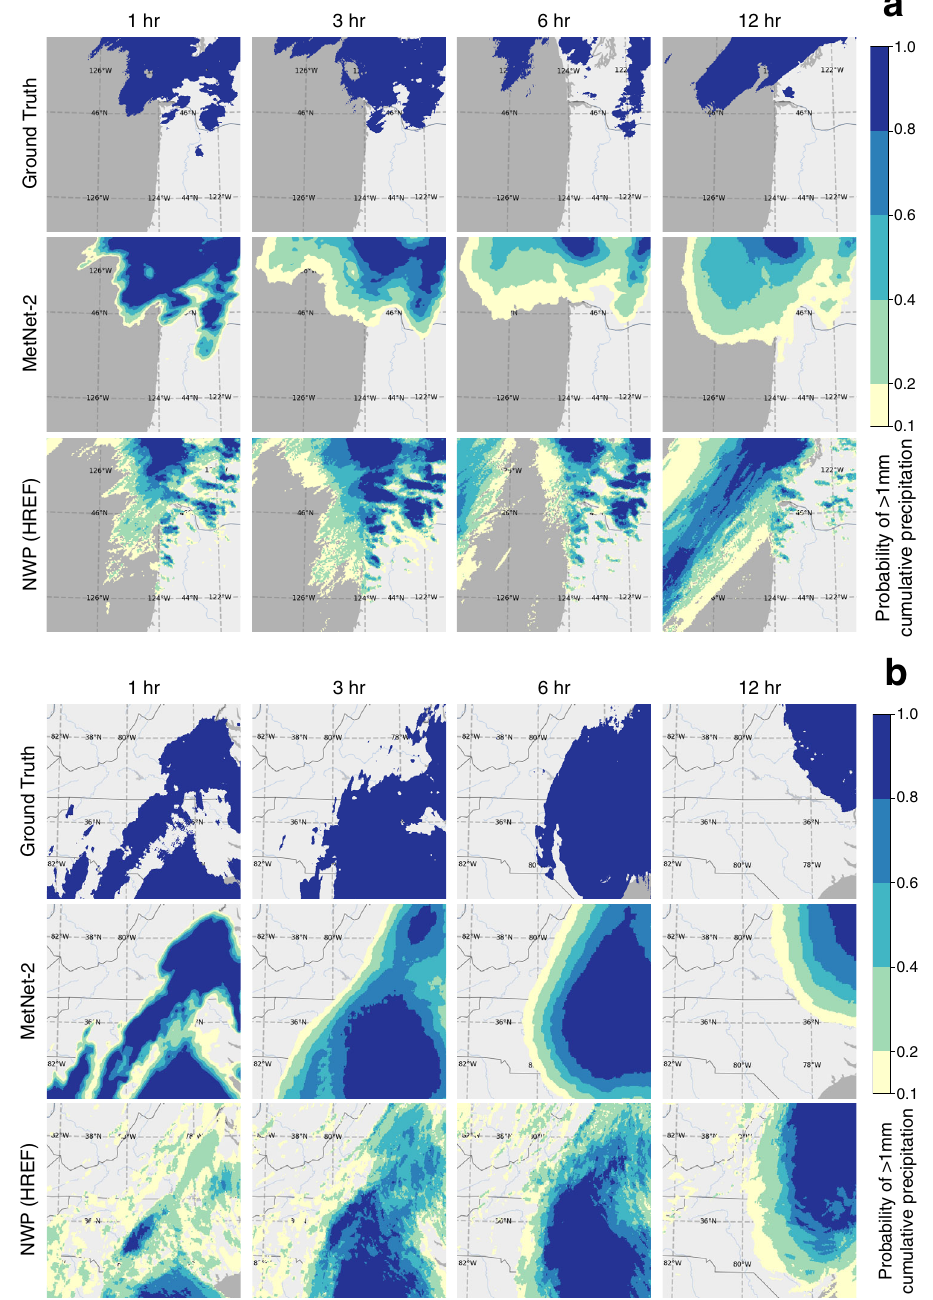
Fig. 4 | Case studies for the models ’ forecasts of cumulative precipitation. Forecasts for gauge-corrected hourly cumulative precipitation ≥ 1mm/h. Each contour region corresponds to the band of probability of precipitation ≥ 1mm/h that the respective model assigns to that region. a Case study for Thu Jan 03 2019